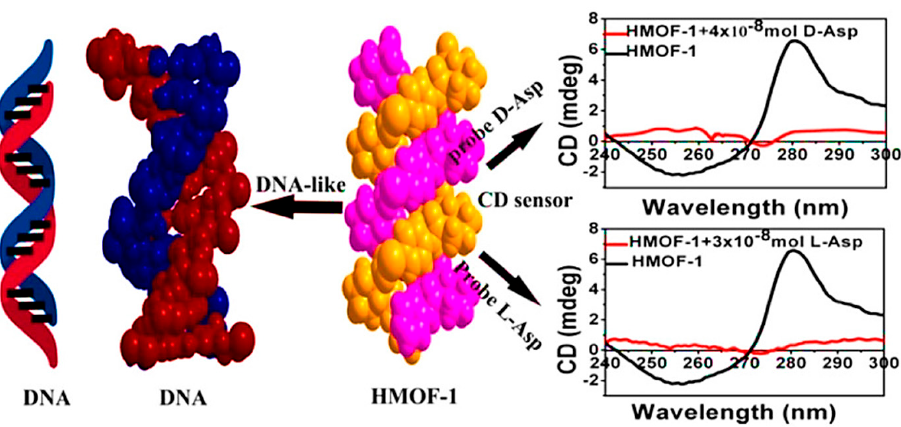
Figure 6. Schematic illustration of the CD spectra of D / L -aspartic acid and a space-filling image of the right-handed double helix HMOF-1. Reprinted (adapted) with permission from [69]. Copyright 2017 American Chemical Society.